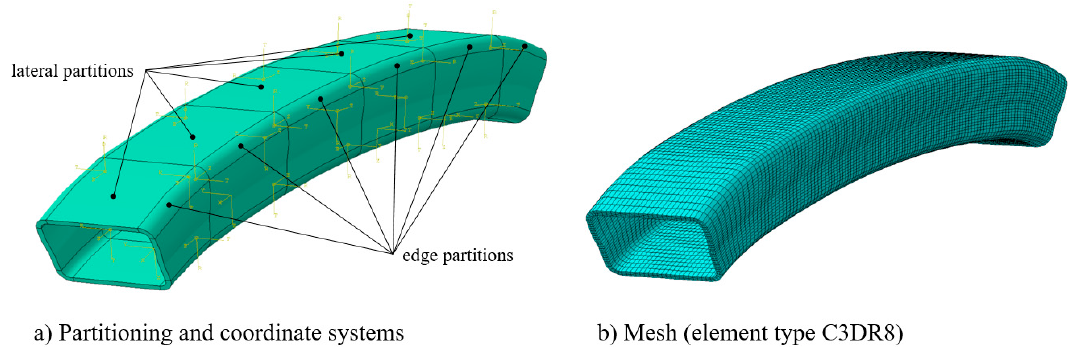
Figure 8. Finite Element (FE) model: ( a ) partitioning and ( b ) meshing.